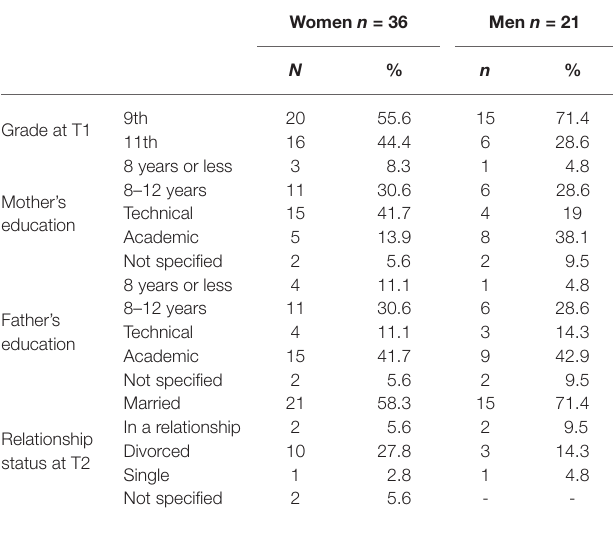
TABLE 1 | Sample distribution by demographic